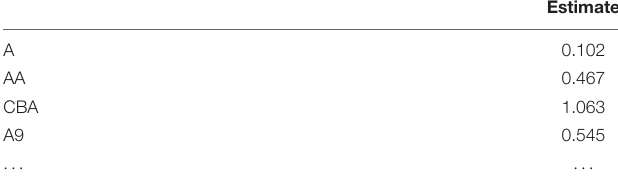
TABLE 8 | Squared multiple